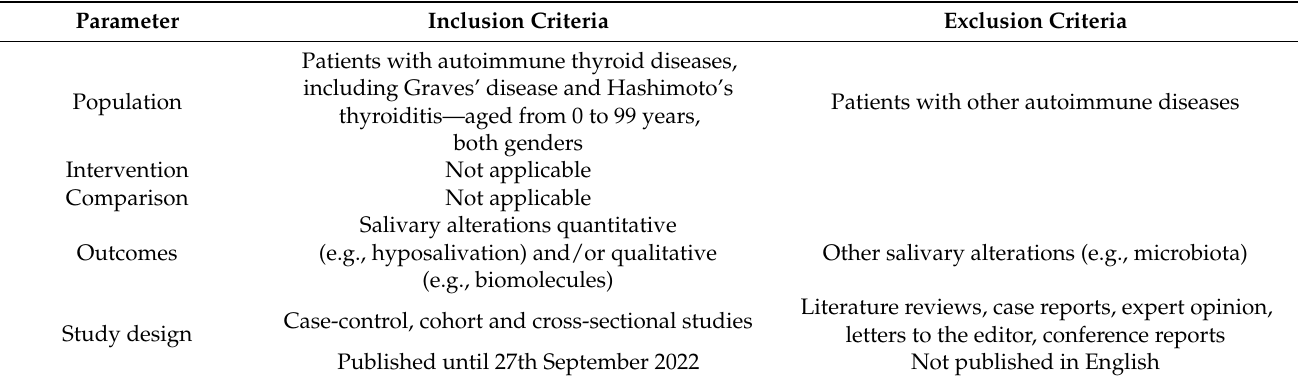
Table 1. Inclusion and exclusion criteria according to PICOS.